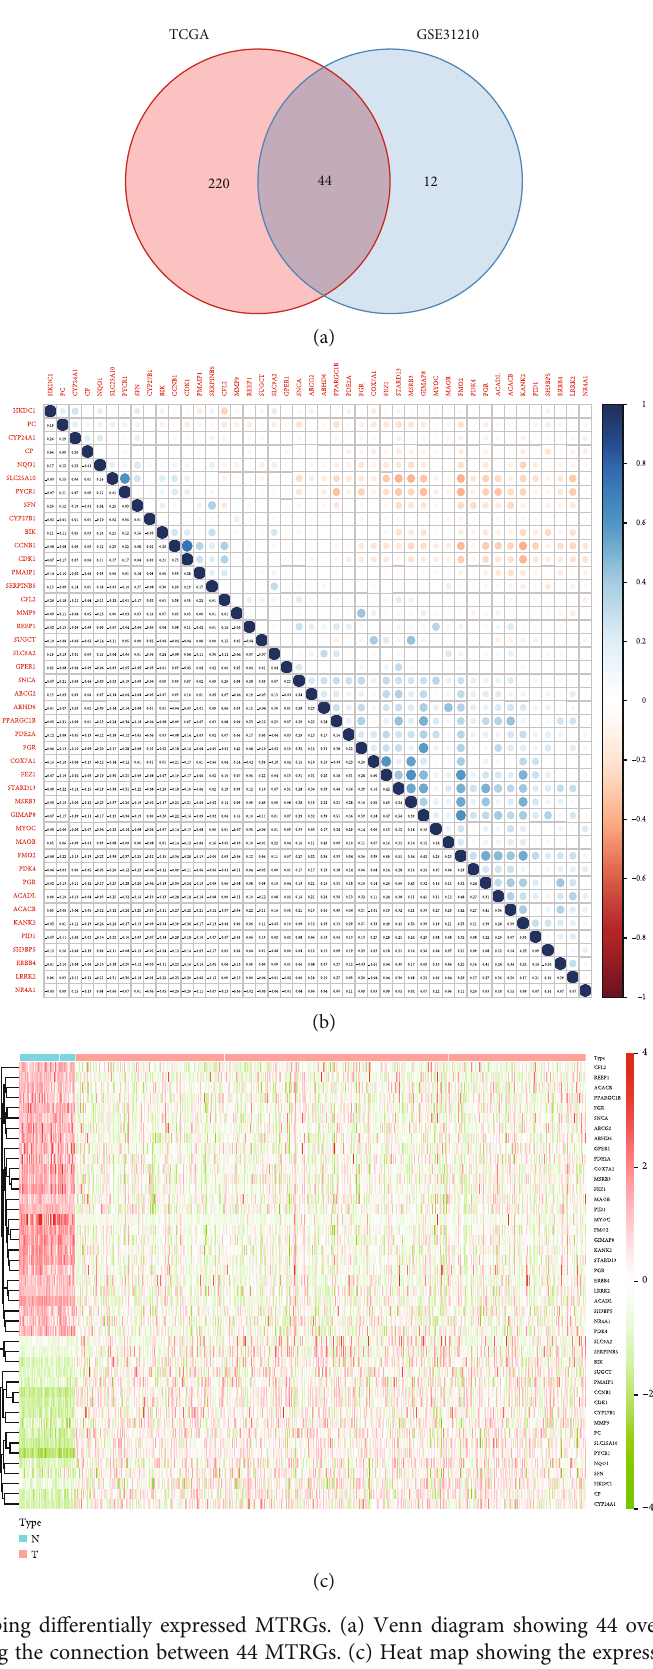
Figure 1: A total of 44 overlapping di ff erentially expressed MTRGs. (a) Venn diagram showing 44 overlapping genes between the two cohorts. (b) Correlogram showing the connection between 44 MTRGs. (c) Heat map showing the expression of 44